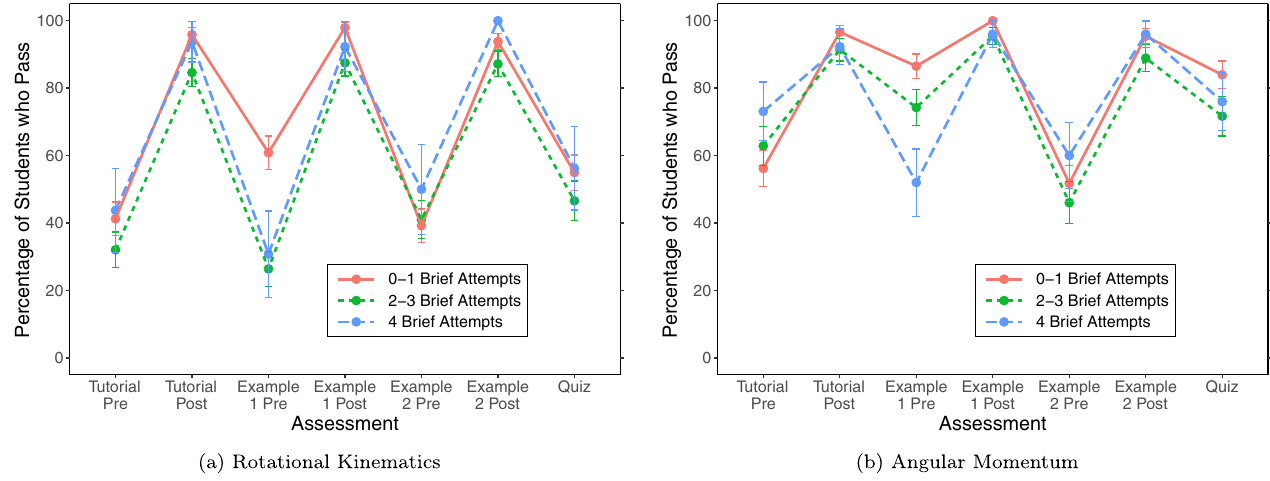
FIG. 3. Comparison of performance on OLMs between students with different numbers of brief attempts: (a) Rotational kinematics and (b) angular momentum. The error bars represent standard error. Passing rates on the on-ramp module is not shown since it is irrelevant to the discussion of transfer.